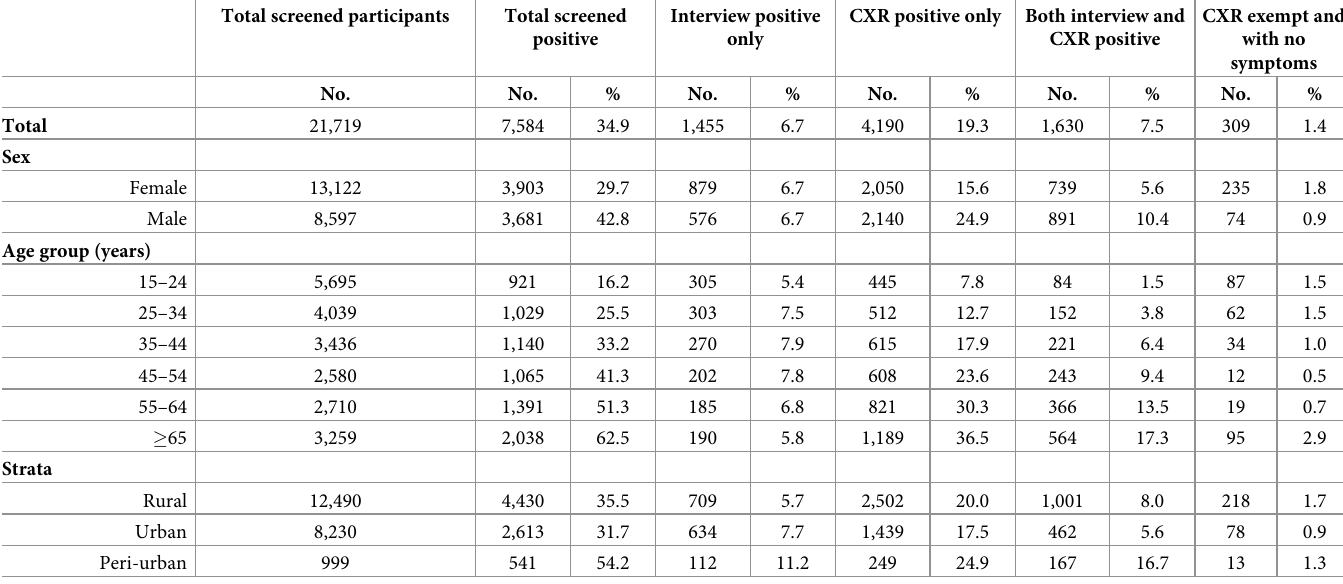
Table 1. Screening outcomes by sex age group and